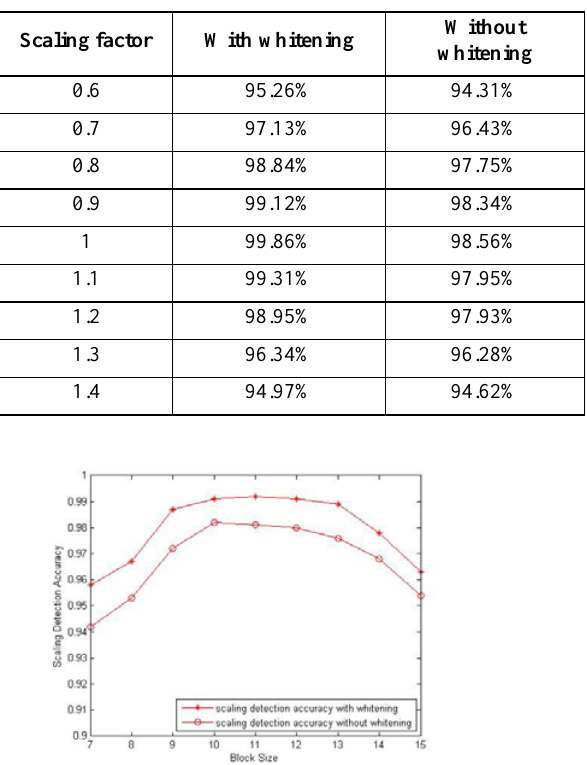
Table 3. Scaling detection accuracy